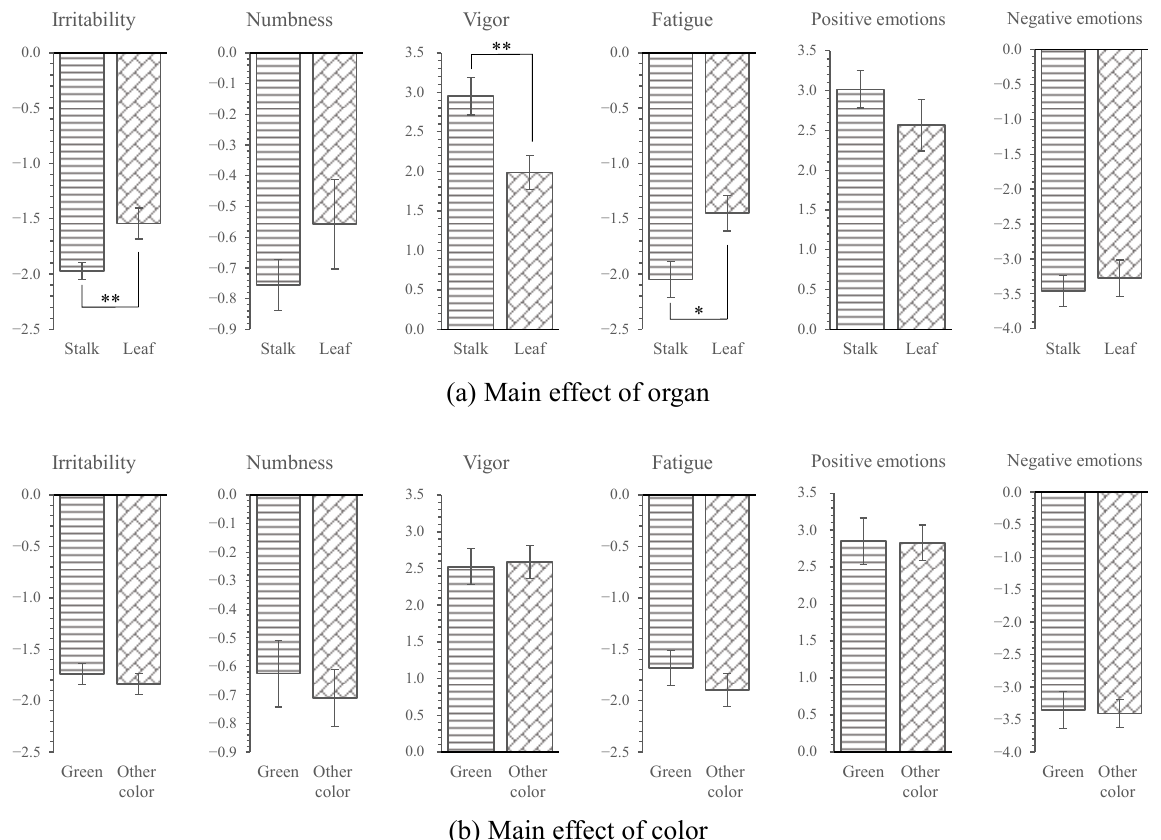
Figure 9. Mean effect of organ and color on psychological indicators. The zero point represents the value measured after participants viewing urban images. n = 300; mean ± SE, * p < 0.05; ** p < 0.01.